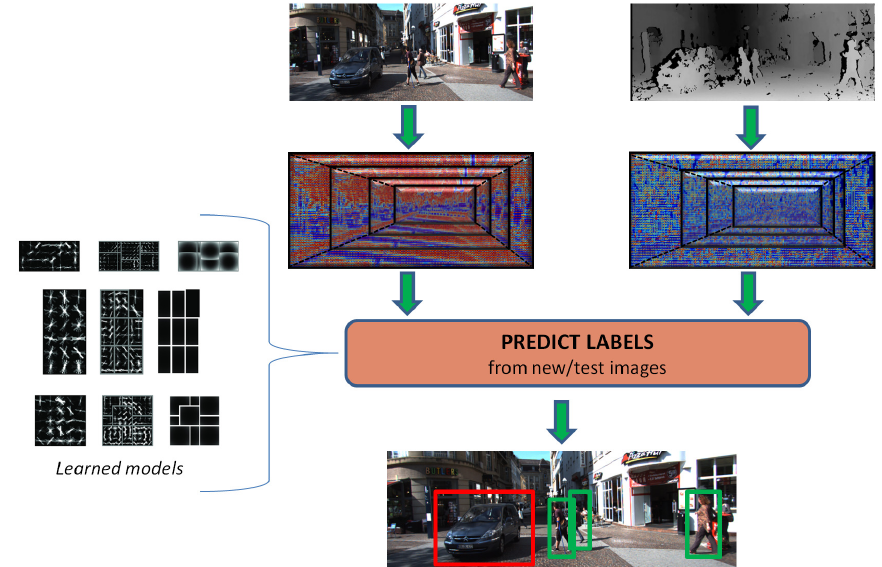
Figure 1. Predicting roads participants from 2.5D data. 3D-aware features from scale pyramids are computed on color and disparity images and incorporated into DPM